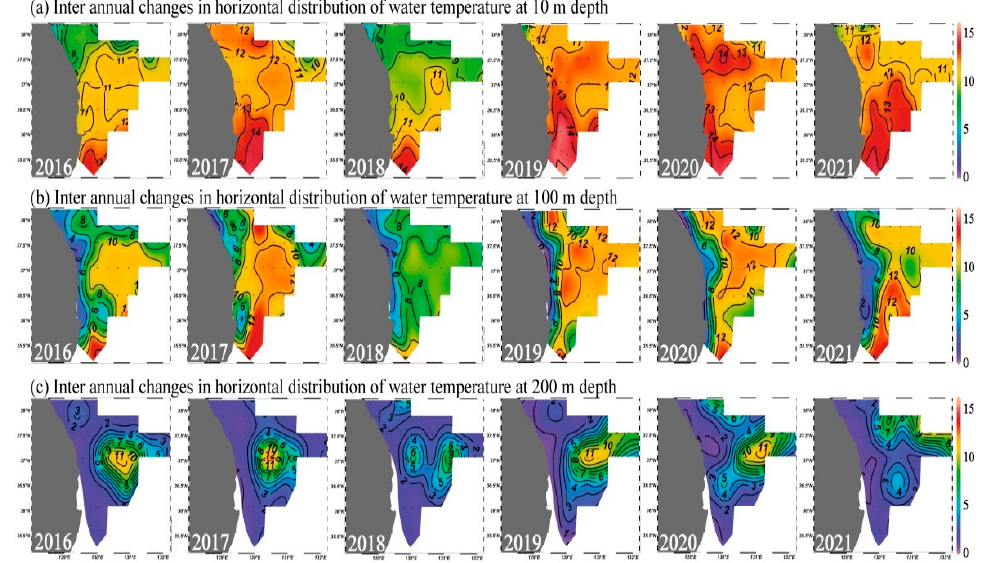
Figure 3. Inter-annual changes in horizontal distribution of water temperature ( ◦ C) at depths of ( a ) 10 m, ( b ) 100 m and ( c ) 200 m in the western part of East/Japan Sea